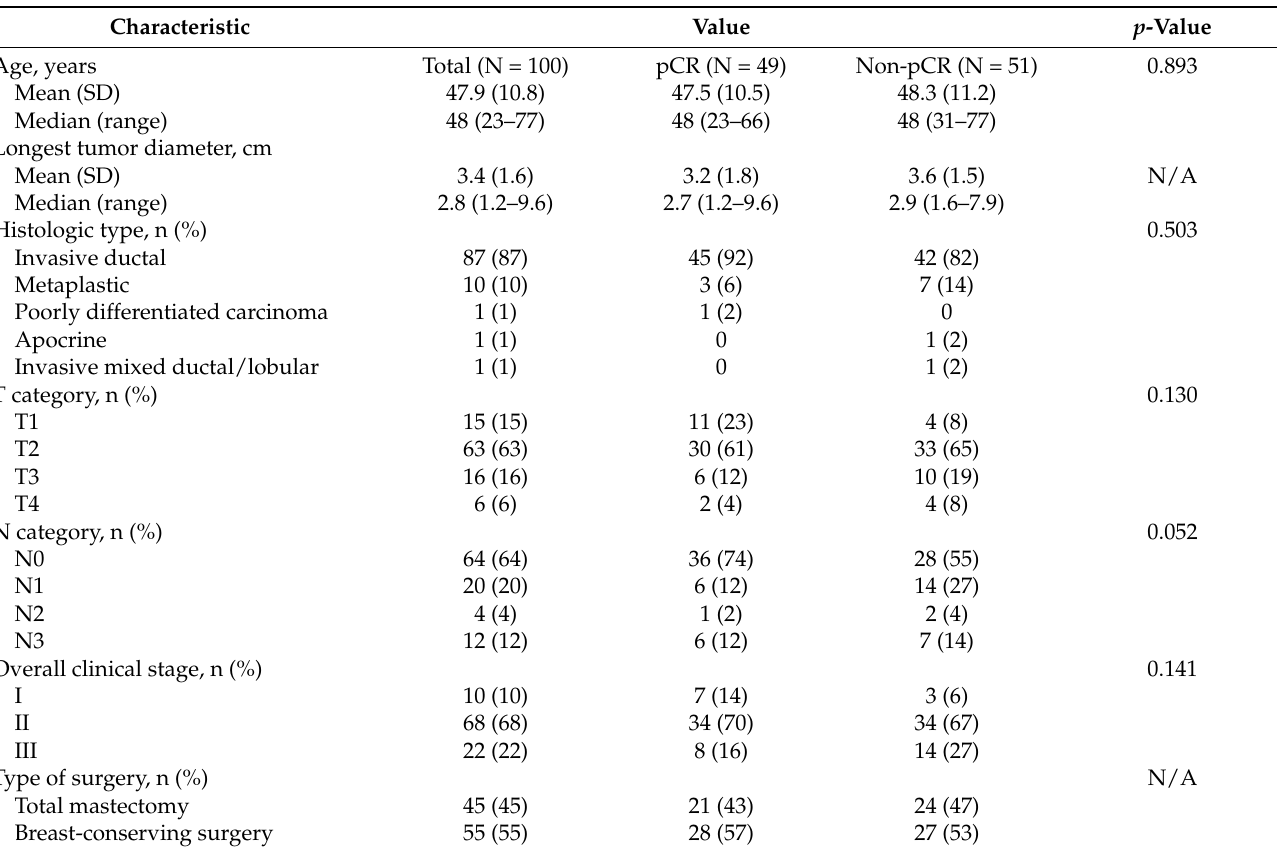
Table 1. Characteristics of the study patients with triple-negative breast cancer who received neoad- juvant systemic therapy.